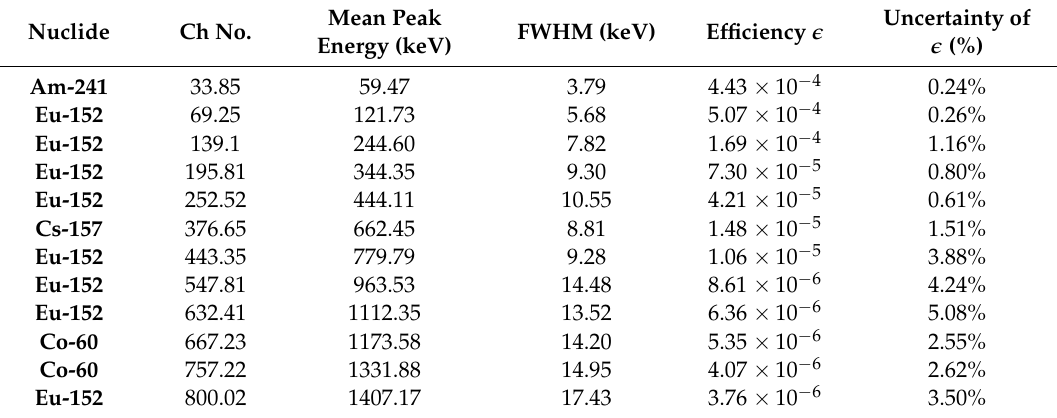
Table 4. Characteristics of the peaks considered for calibration retrieved from the spectrum acquired with the CZT.